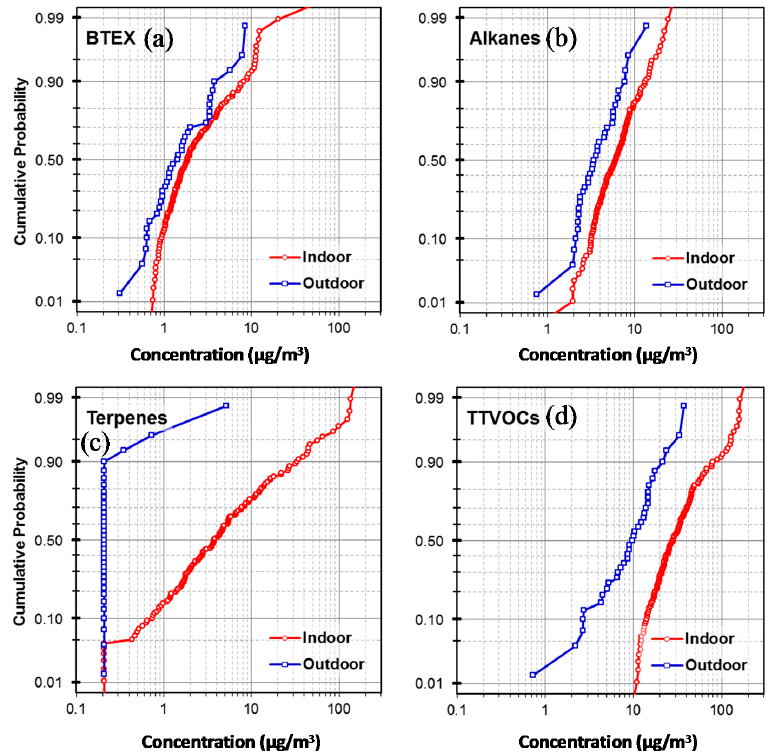
Figure 1. Probability plots of ( a ) BTEX (Benzene, toluene, ethylbenzene and xylene), ( b ) alkanes (C 6 – C 7 , C 11 –C 16 ), ( c ) terpenes ( α -pinene and d -limonene), and ( d ) TTVOCs (total target VOCs) in 144